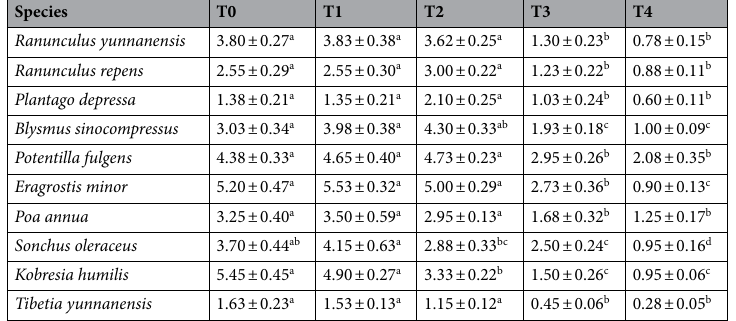
Table 1. Effects of trampling disturbance on plant height (mean ± SE) of individual plant species. T0, T1, T2, T3, T4 and T5 represents experimental lanes receiving 0, 25, 75, 250 and 500 trampling passes, respectively. Different letters indicate statistically significant difference at p < 0.05.